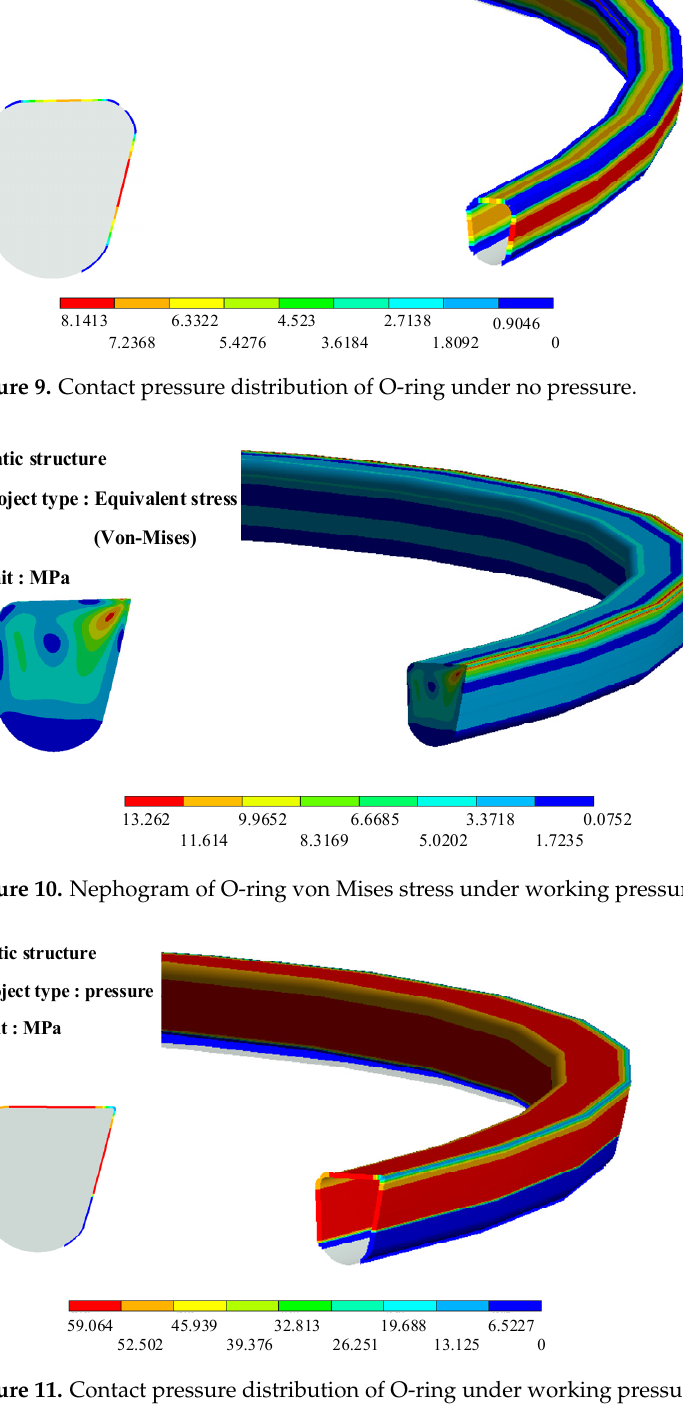
Figure 11. Contact pressure distribution of O-ring under working pressure.